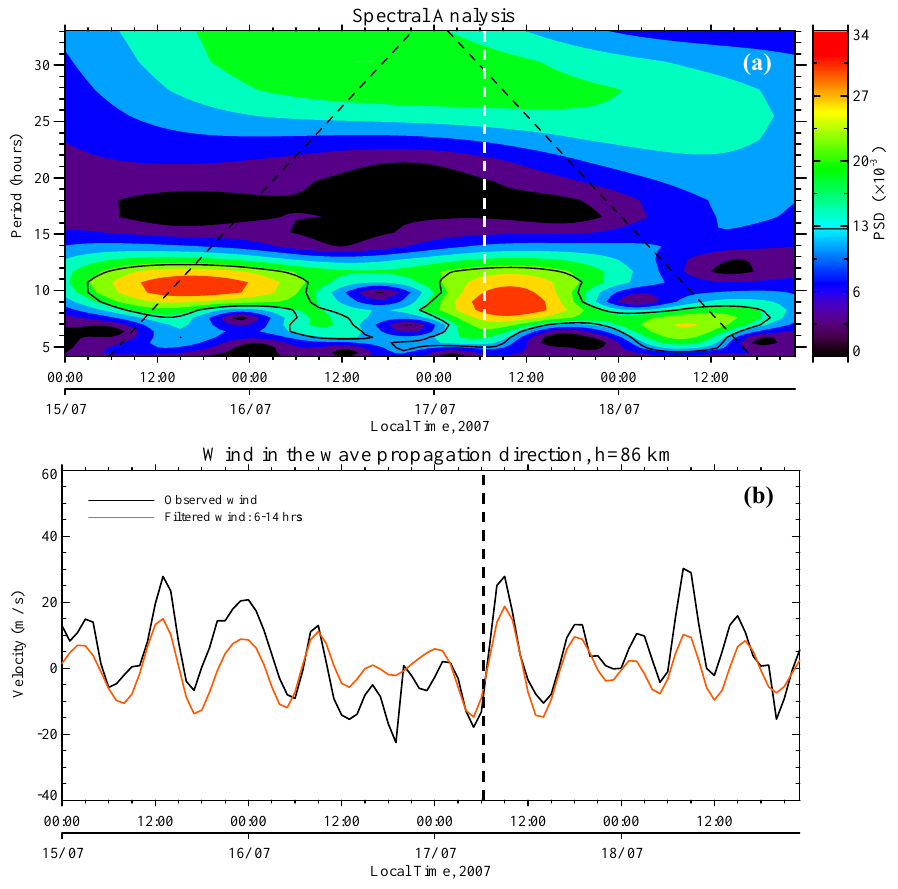
Fig. 6. (a) Spectral analysis obtained by the wavelet technique applied to the original wind time series, projected along the wave, as showed in the panel (b) in black. (b) Time series of the original wind projected in the wave propagation direction (black), for the high of 86km, together with the filtered wind for the periods between 6 and 14h, i.e., the typical oscillations showed in the panel (a) .